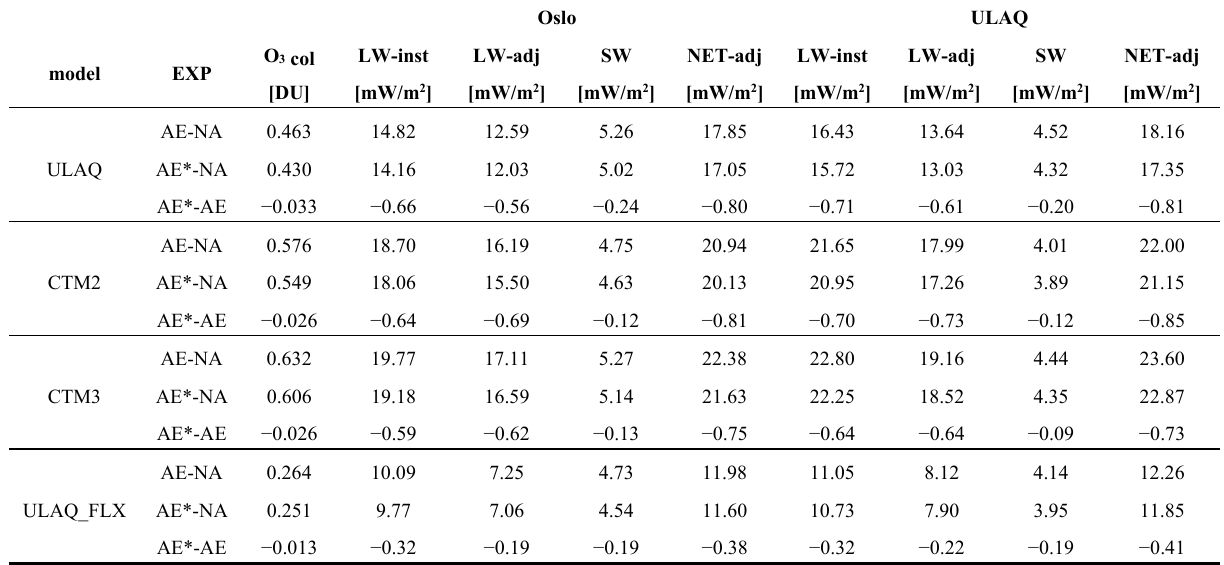
Table 4. As in Table 3, but for total sky conditions. LW-RF and NET-RF with stratospheric temperature adjustment are also included